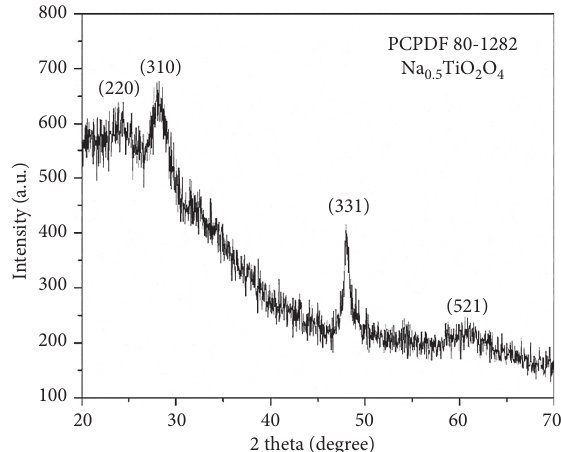
Figure 3: The XRD pattern of the GTNT composites.